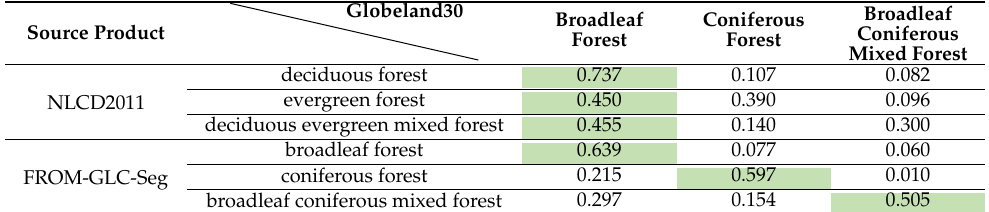
Table 7. Result of similarity matrix of ontology mapping based on